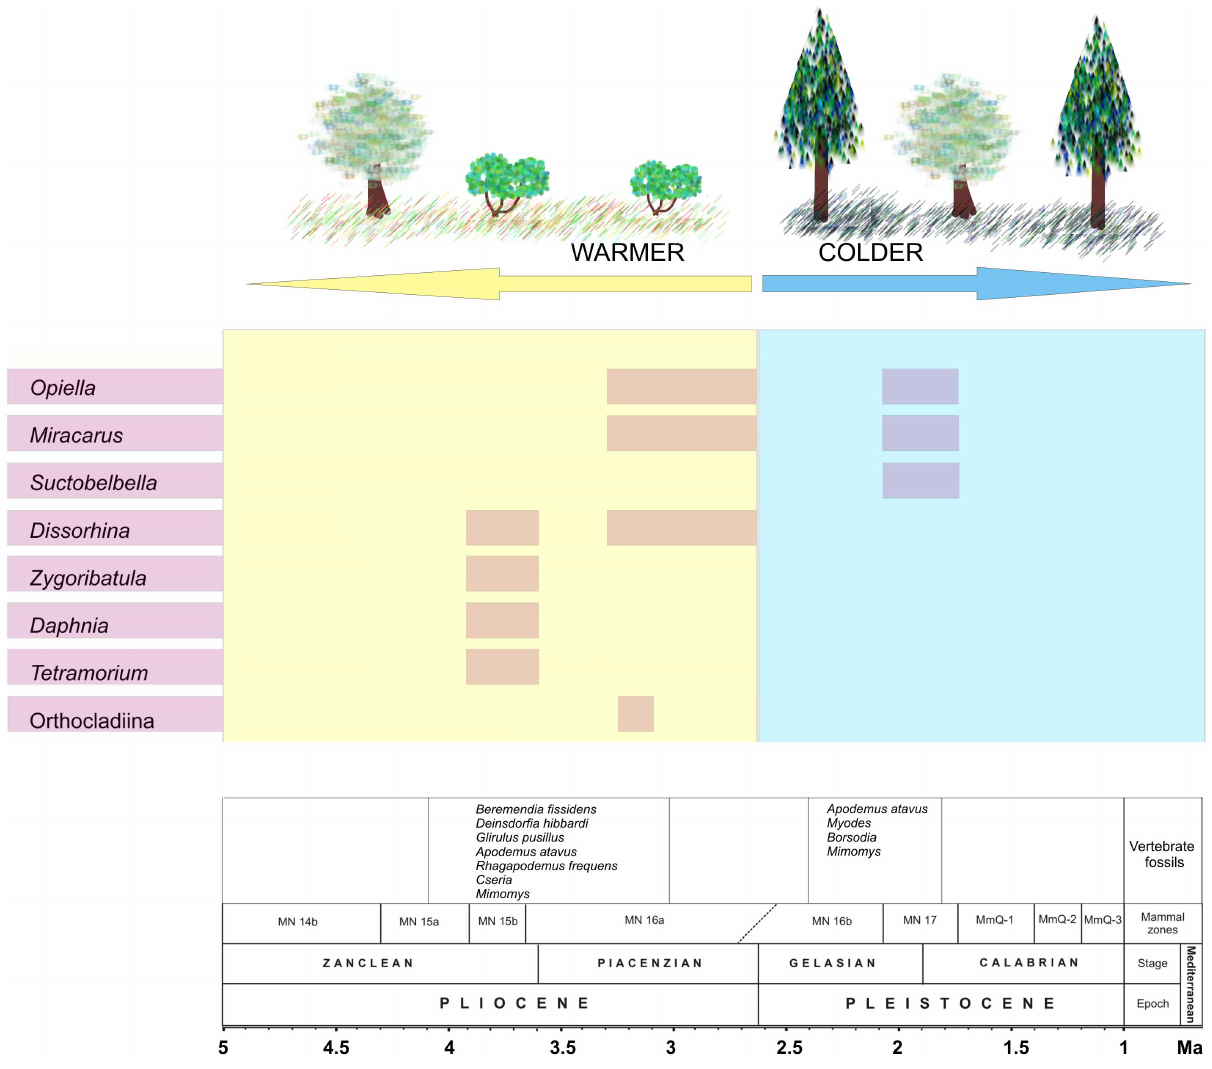
Fig. 5. Invertebrate fossils found in the studied caves, correlated with climate, vegetation and fossil